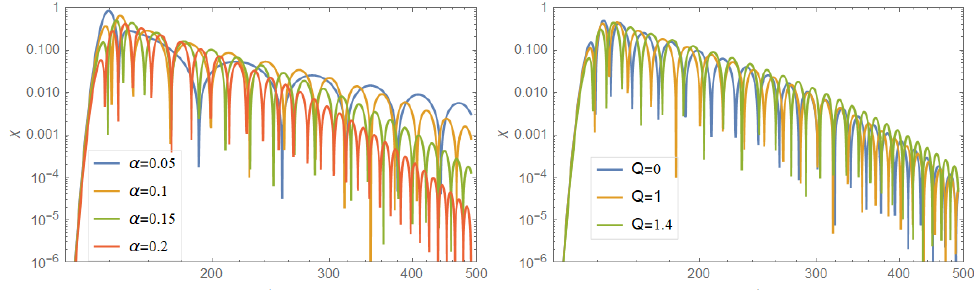
Figure 2. Time domain profiles for the scalar perturbations. The left panel indicates the decay of the perturbation for different α , and the right panel indicates the decay of the perturbation for different Q .